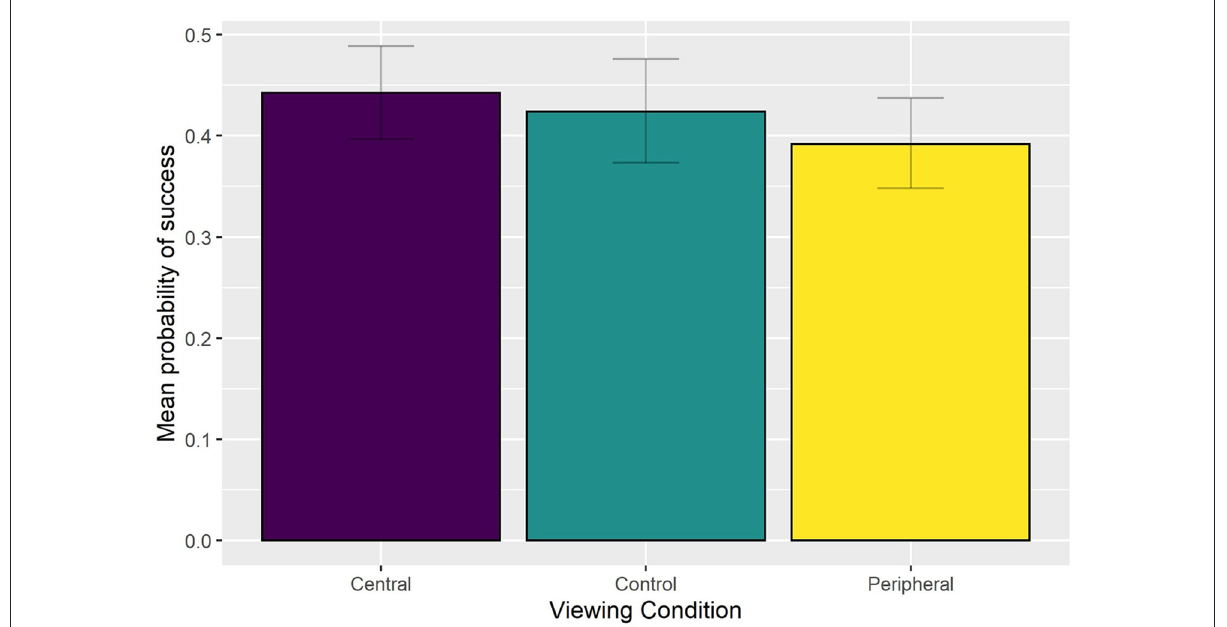
FIGURE2 Group mean probability of a successful interception as a function of Viewing Condition.